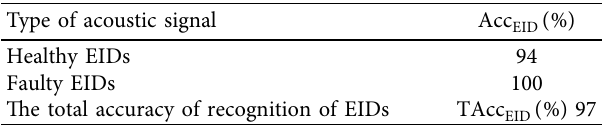
Table 3: The classification accuracy on the training dataset and testing dataset using the PAR model with different classification methods.